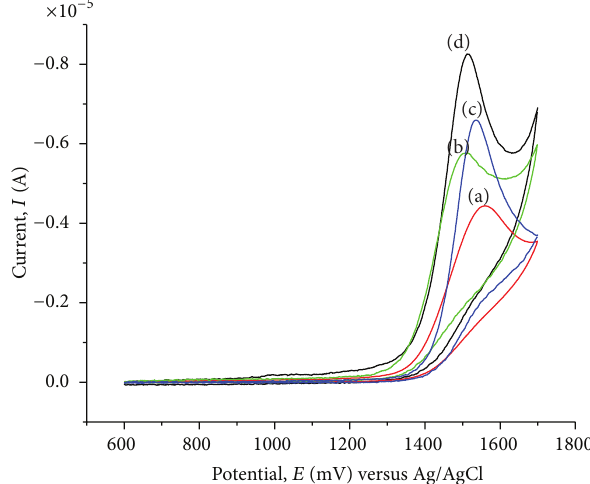
Figure 2: CVs of AQMCPE in 0.1M of different supporting electrolytes (a) acetate, (b) phosphate, (c) sulfuric acid, and (d) per-chloric acid in the presence of 1mM caffeine; at a scan rate of